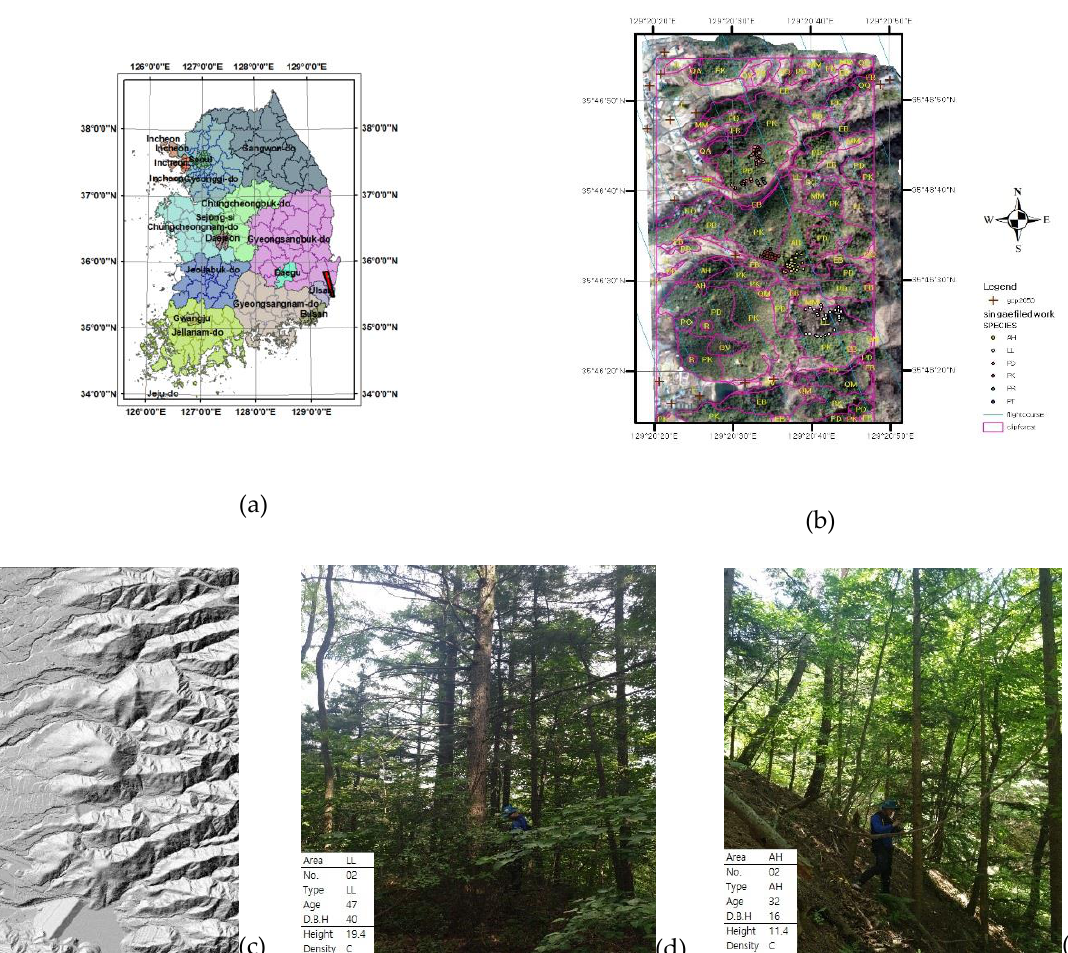
Figure 1. ( a ) The location of the study area marked on the forest type map, ( b ) The ground control points and the fieldwork points on an Unmanned Aerial Vehicle (UAV) orthoimages, ( c ) Aerial LIDAR Scanner’s (ALS’s) Digital Elevation Models hillshade ( d ) LL photo in a fieldwork, ( e ) Abies holophylla (AH) photo in a fieldwork.